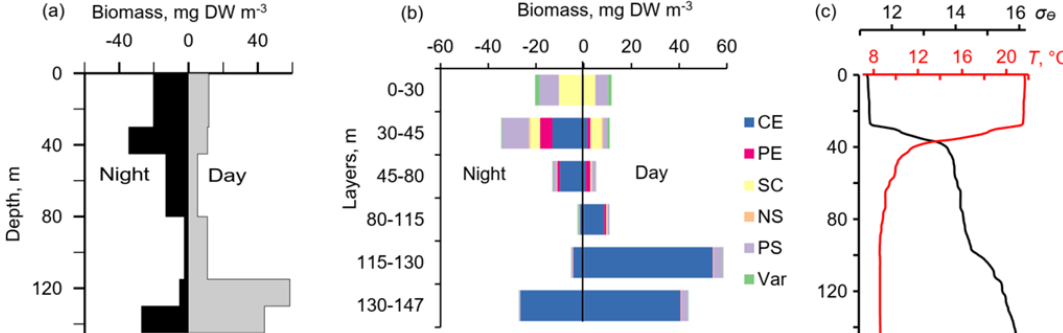
Figure 8. Day–night vertical distribution of (a) total mesozooplankton biomass, (b) zooplankton composition, and (c) temperature ( T , ◦ C) and density ( σ (cid:50) ) near the mooring site at 22:00–23:00 on 4 October (night) and 11:05–11:50 on 5 October (day) 2016. Temperature and density profiles (c) indicate the selection of sampling strata. CE – Calanus euxinus ; PE – Pseudocalanus elongatus ; SC – small crustaceans; NS – Noctiluca scintillans ; PE – Parasagitta setosa ; Var –